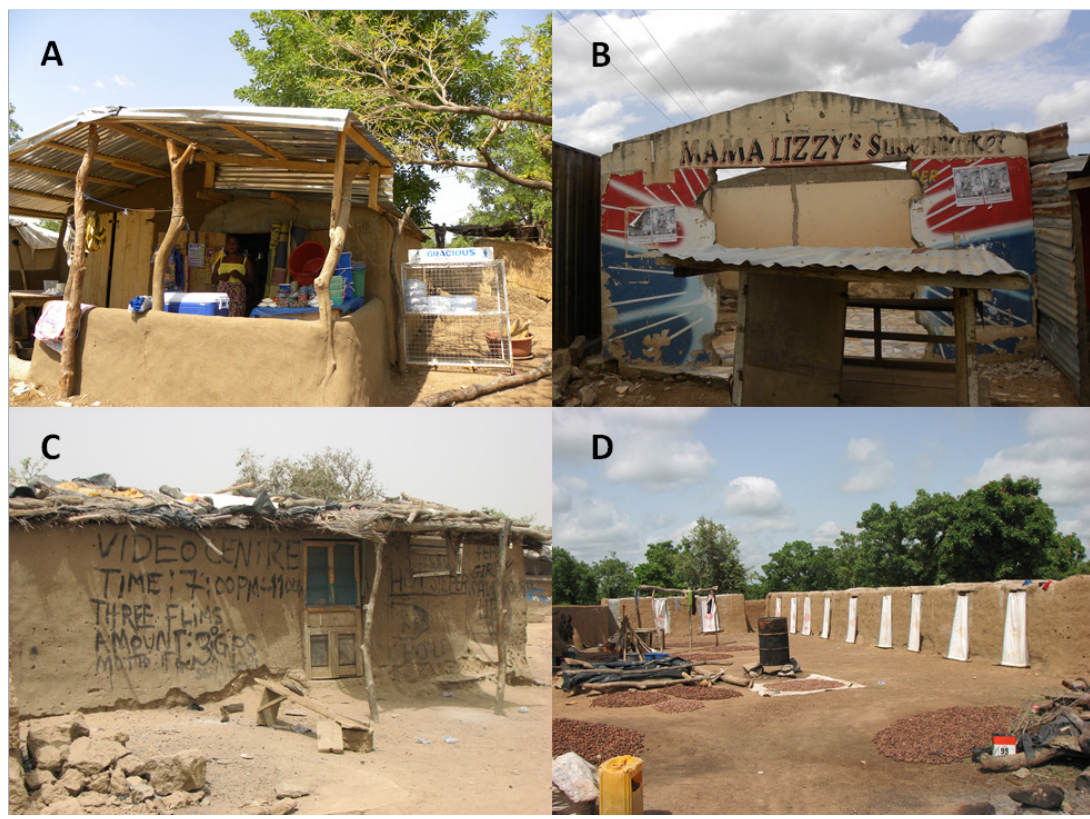
Figure 2. Examples of income generating activities linked to ASGM at our study sites in Ghana: ( A ) Shop selling food and water (Kejetia mining site, Talensi District, photograph Mark L. Wilson), ( B ) Outdoor “Supermarket” (Kejetia mining site, Talensi District, photograph Mark L. Wilson), ( C ) Video Centre for viewing entertainment (Kejetia mining site, Talensi District, photograph Elisha Renne), ( D ) Bathing stalls for short-term rental (Kejetia mining site, Talensi District, photograph Elisha